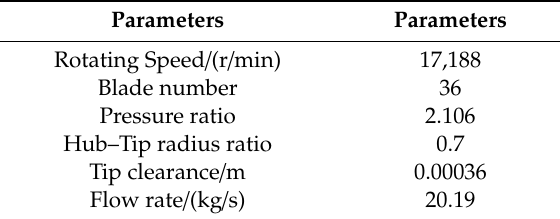
Table 1. The design parameters of Rotor37.